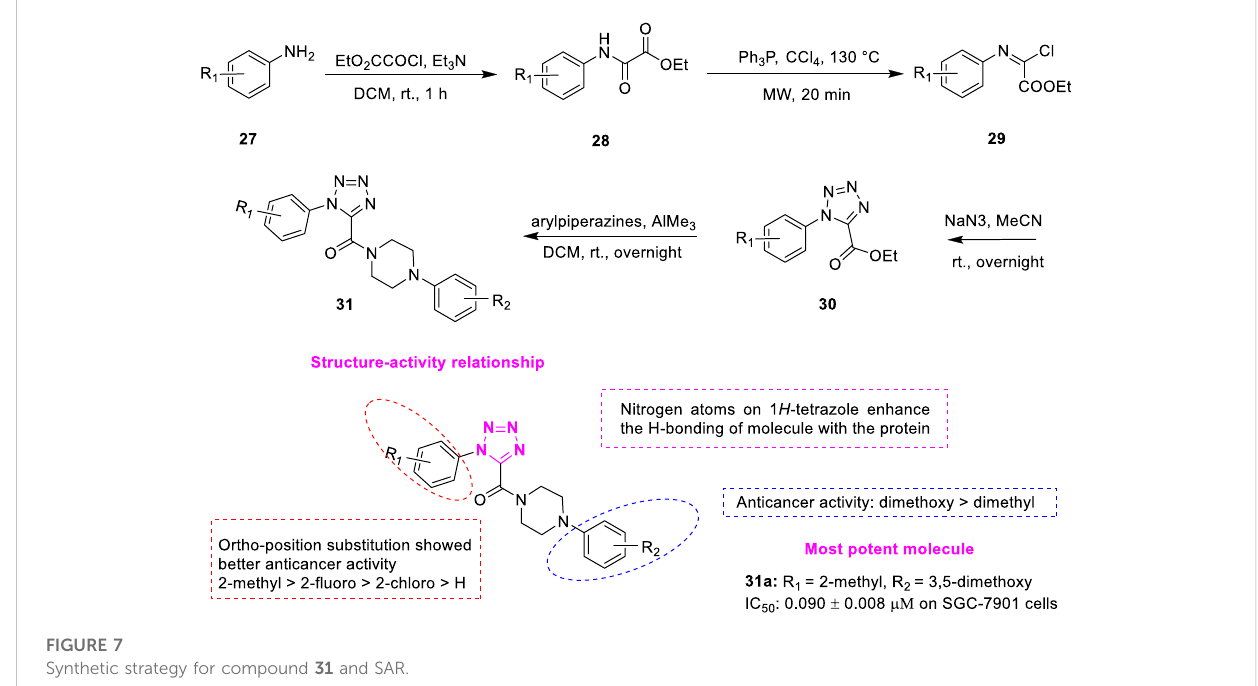
FIGURE 7 Synthetic strategy for compound 31 and